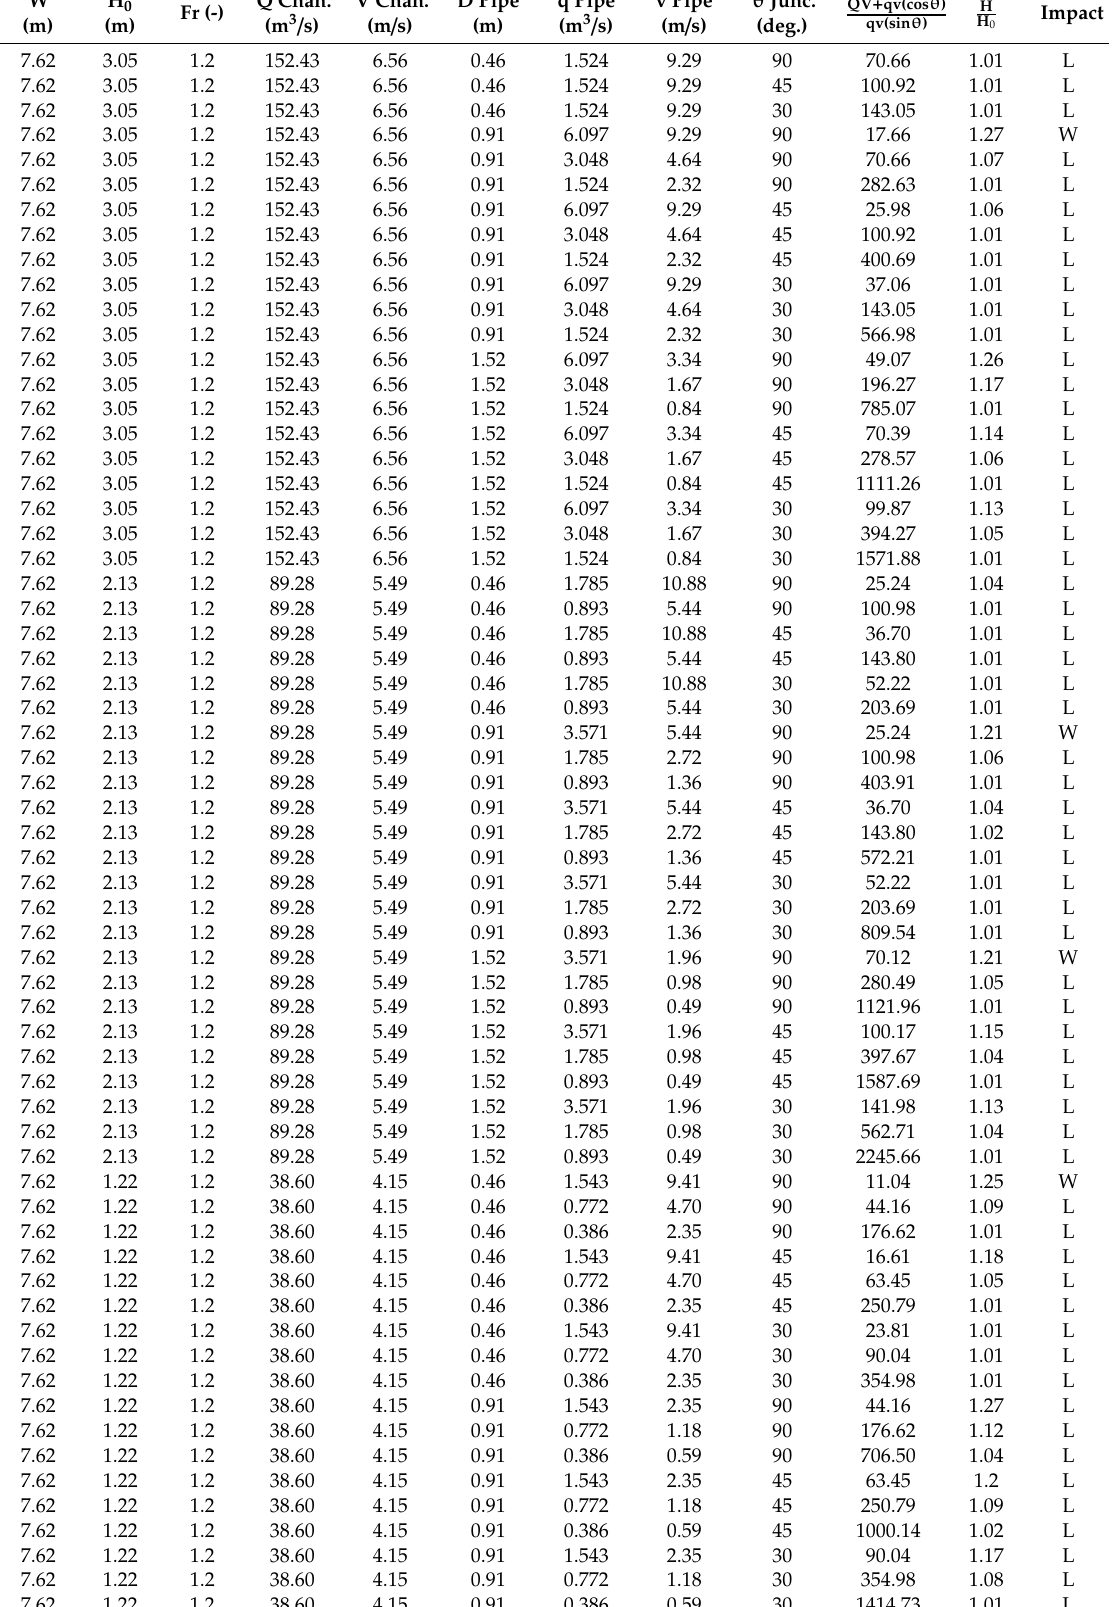
Table A5. FLOW-3D simulation results for W = 7.62 m (25 (cid:48) ) and Fr =